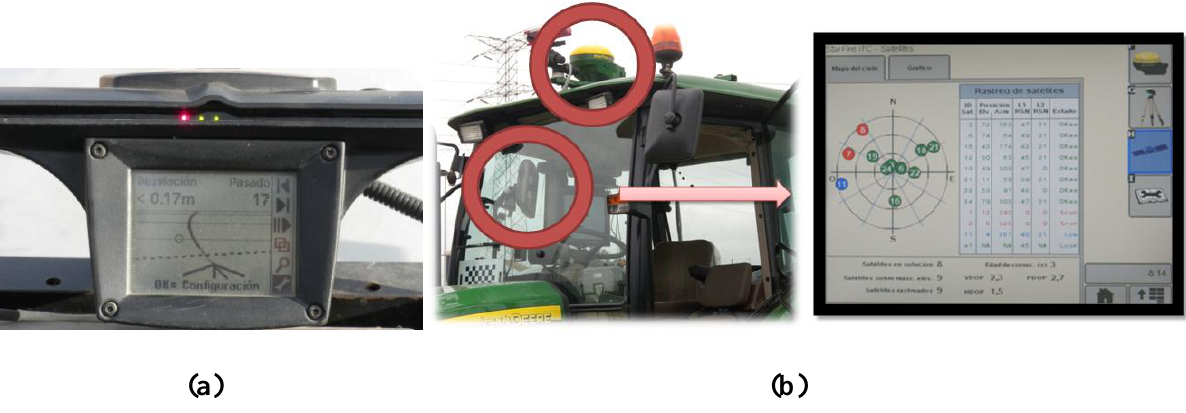
Figure 7. GPS for agricultural operations: (a) Lightbar steering assistance system. (b) DGPS onboard